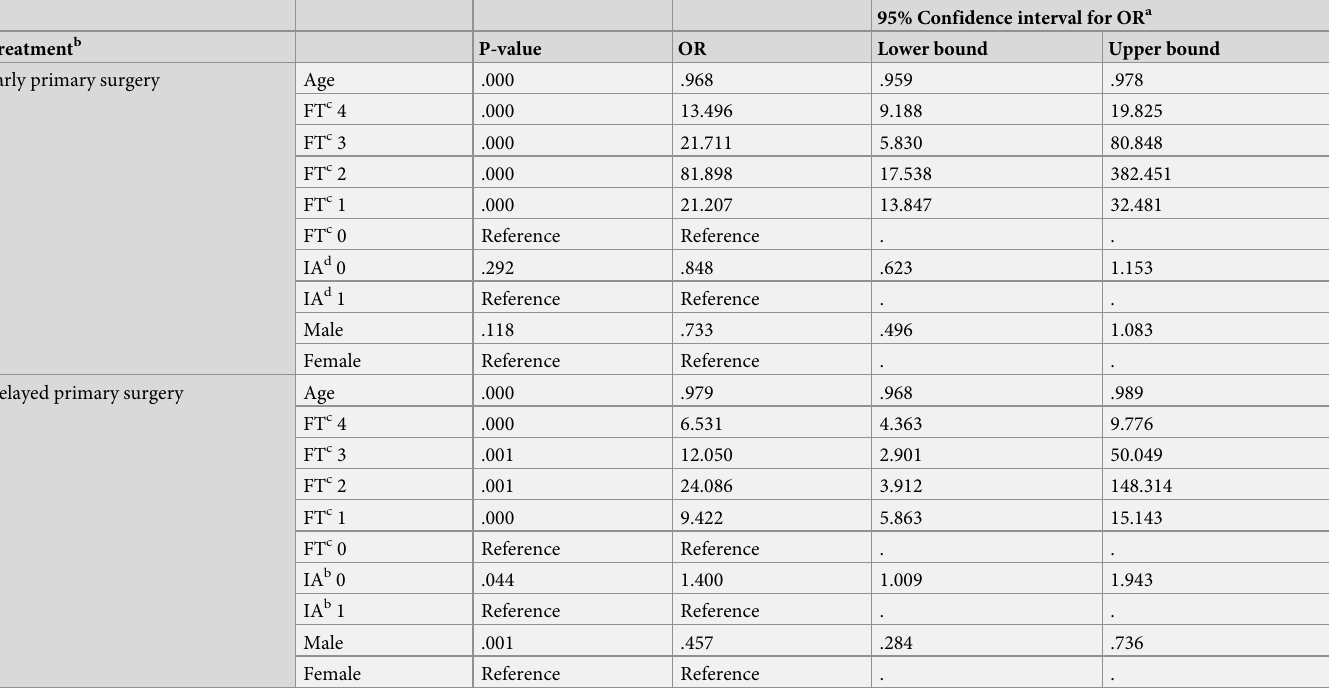
Table 3. Multivariate analysis with multinomial linear regression for treatment (nonoperative, early or delayed primary surgery) as the dependent variable in a ret- rospective cohort study of 1,635 DRFs in two hospitals in Sweden in